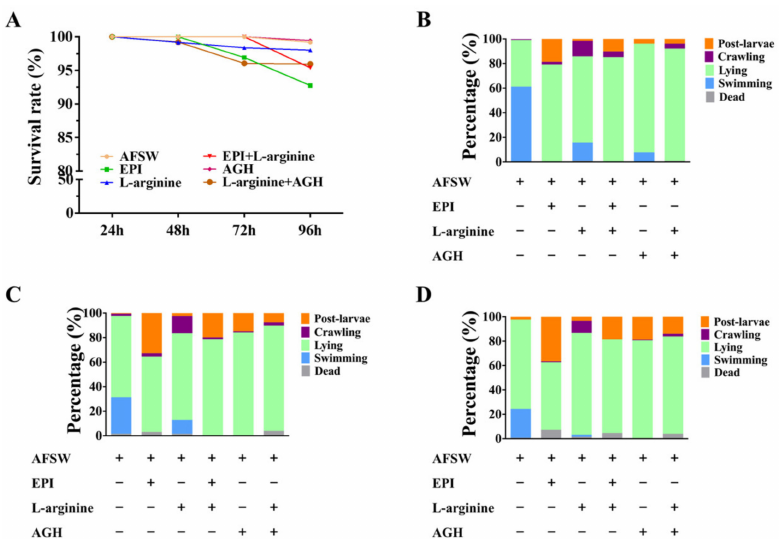
Figure 3. Survival rate and behavior of the larvae exposed to L-arginine and AGH. ( A ) Survival rates after exposure to L-arginine and AGH for 24, 48, 72, and 96 h. ( B ) Larval behavior on exposure to L-arginine and AGH for 48 h, ( C ) 72, and ( D ) 96